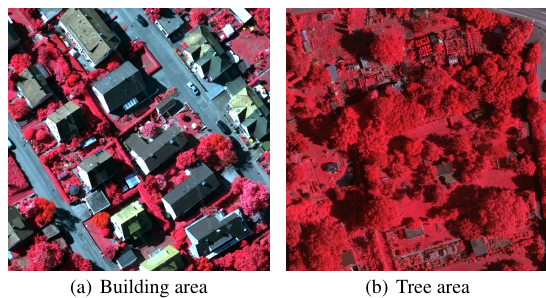
Figure 5. Two examples of the testing data: building area and tree area.